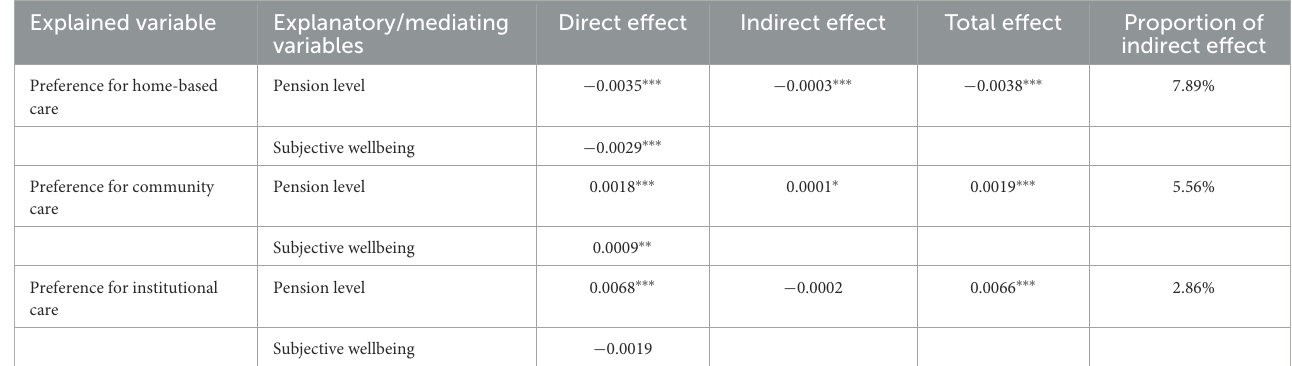
TABLE 5 Decomposition of